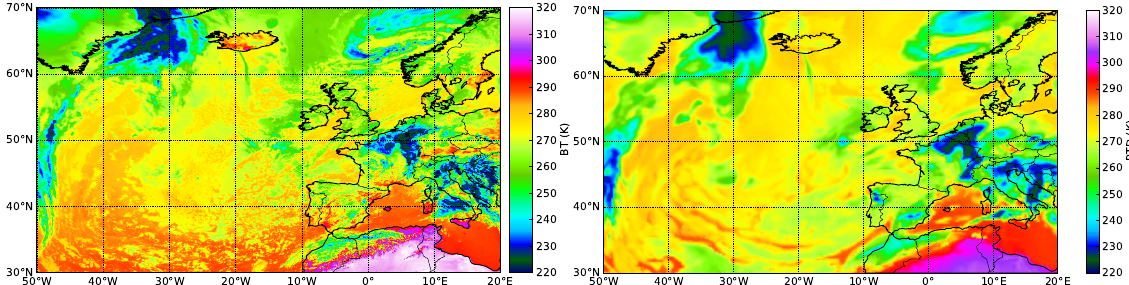
Fig. 4. Left panel: brightness temperatures as measured by the 10.8µm channel of the SEVIRI instrument. Right panel: the 10.8µm brightness temperature as simulated by the MYSTIC radiative transfer model. The simulation includes ECMWF ice and water cloud in addition to the FLEXPART ash cloud.